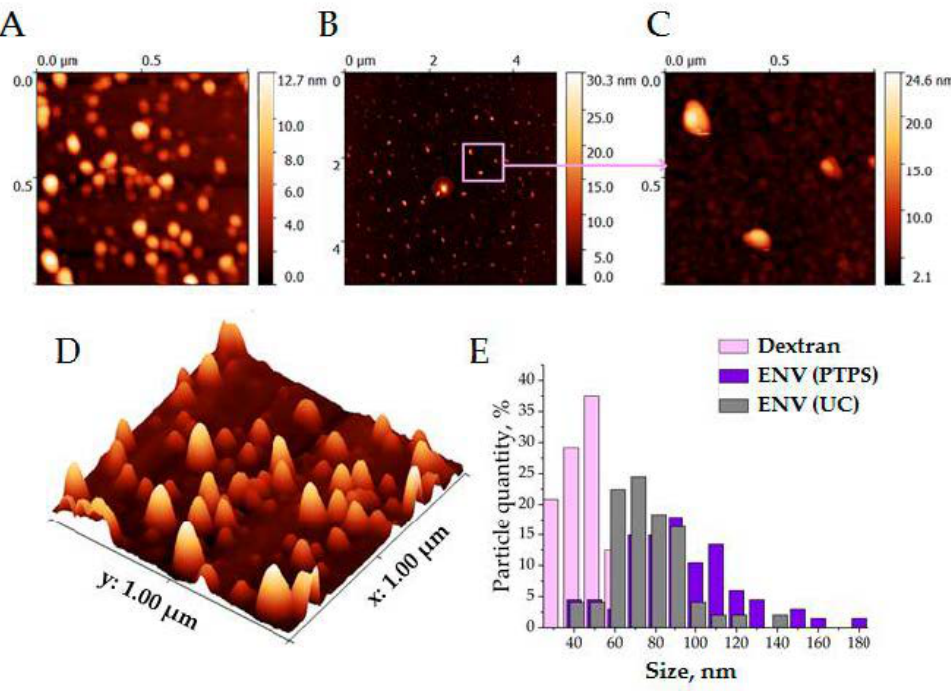
Figure 8. Particles concentrated in lower phase 2 (LP2) visualized by atomic force microscopy (AFM). ( A , D ) Images of ENVs obtained by ultracentrifugation as control; ( B , C ) images of ENVs isolated by PTPS; ( E ) the result of statistical processing of AFM